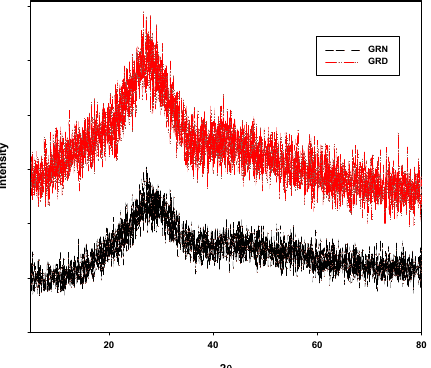
Figure 1. XRD spectra of GRN and GRD glass samples.